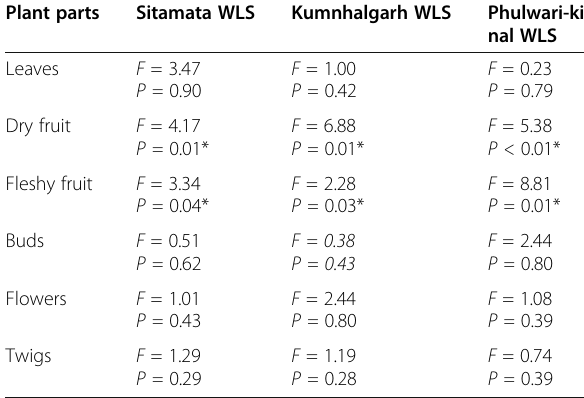
Table 2 Comparison of plant parts consumption between seasons in each of the three wildlife sanctuaries